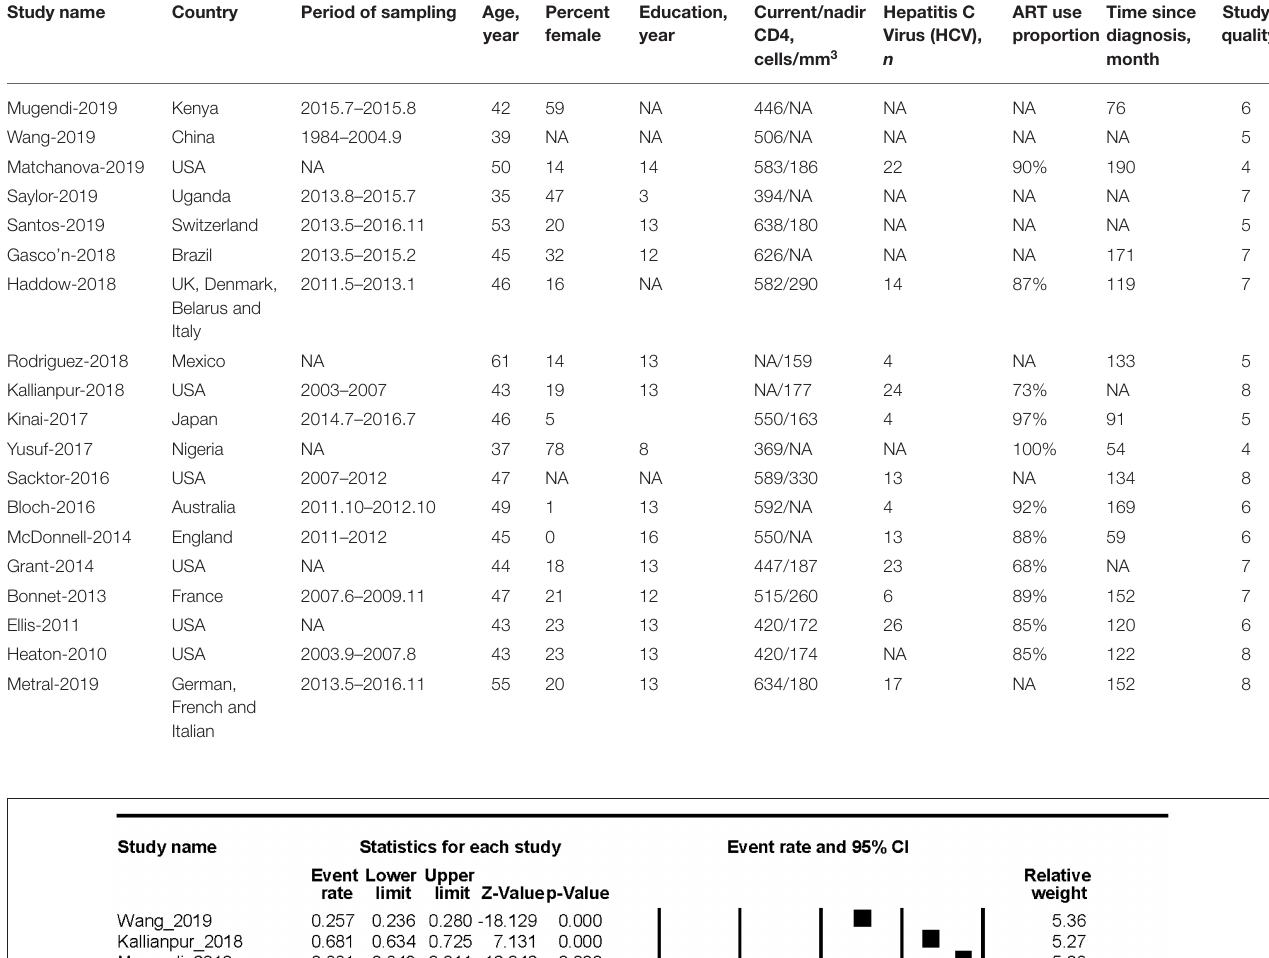
TABLE 1 | Study characteristics.